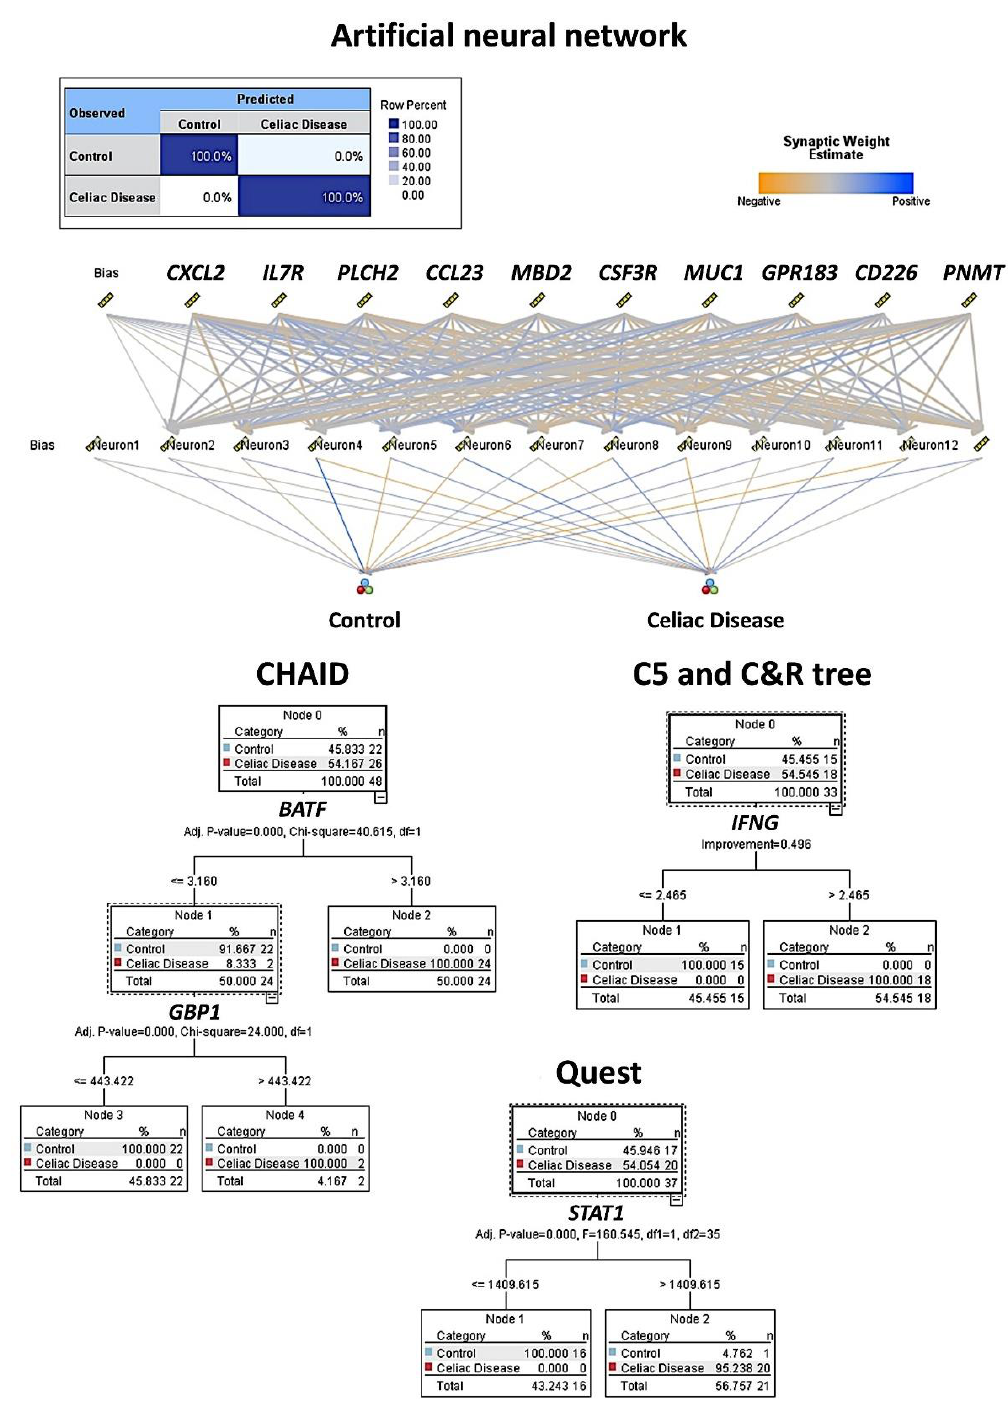
Figure 3. Machine learning and artificial neural network analysis for predicting celiac disease. This figure shows the results of the modeling of celiac disease using an artificial neural network, CHAID, C5, C & R, and Quest decision trees. The overall accuracy ranged from 96% to 100% using as predictors the gene expression (transcriptomic) data of the autoimmune discovery panel.